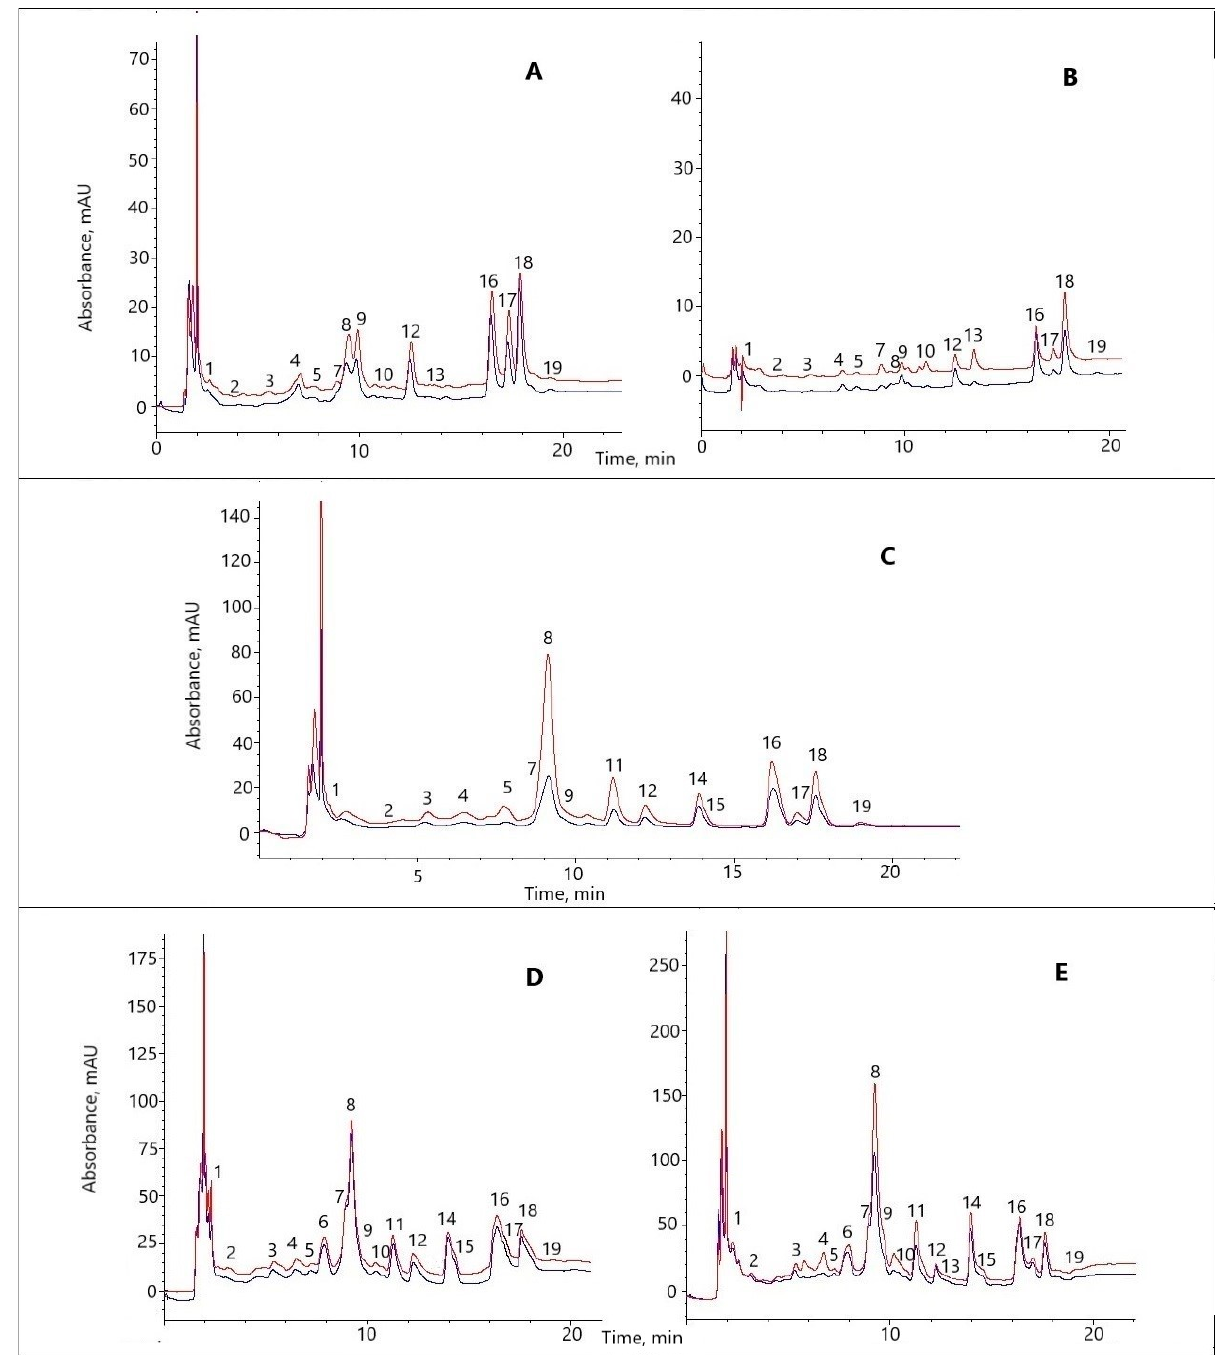
Figure 1. Representative sections of HPLC chromatograms of the extracts of the aboveground part of strawberry cv. ‘Solnechnaya polyanka’ plants. ( A ) The in vitro multiplication stage, ( B ) in vitro rooting stage, ( C ) ex vitro acclimation stage, ( D ) greenhouse conditions, ( E ) field conditions. Black curve: − MC treatment; red curve: +MC treatment. MC: mechanocomposite. Peaks: 1, gallic acids; 2, neochlorogenic acid; 3, (+)-catechin; 4, p -hydroxybenzoic acid; 5, epigallocatechin gallate; 6, ellagic acid derivative 1; 7, caffeic acid; 8, vanillic acid; 9, syringic acid; 10, p -coumaric acid; 11, ellagic acid derivative 2; 12, ellagic acid derivative 3; 13, ferulic acid; 14, quercetin glycoside 1; 15, quercetin glycoside 2; 16, ellagic acid derivative 4; 17, ellagic acid derivative 5; 18, ellagic acid; and 19, kaempferol rutinoside.